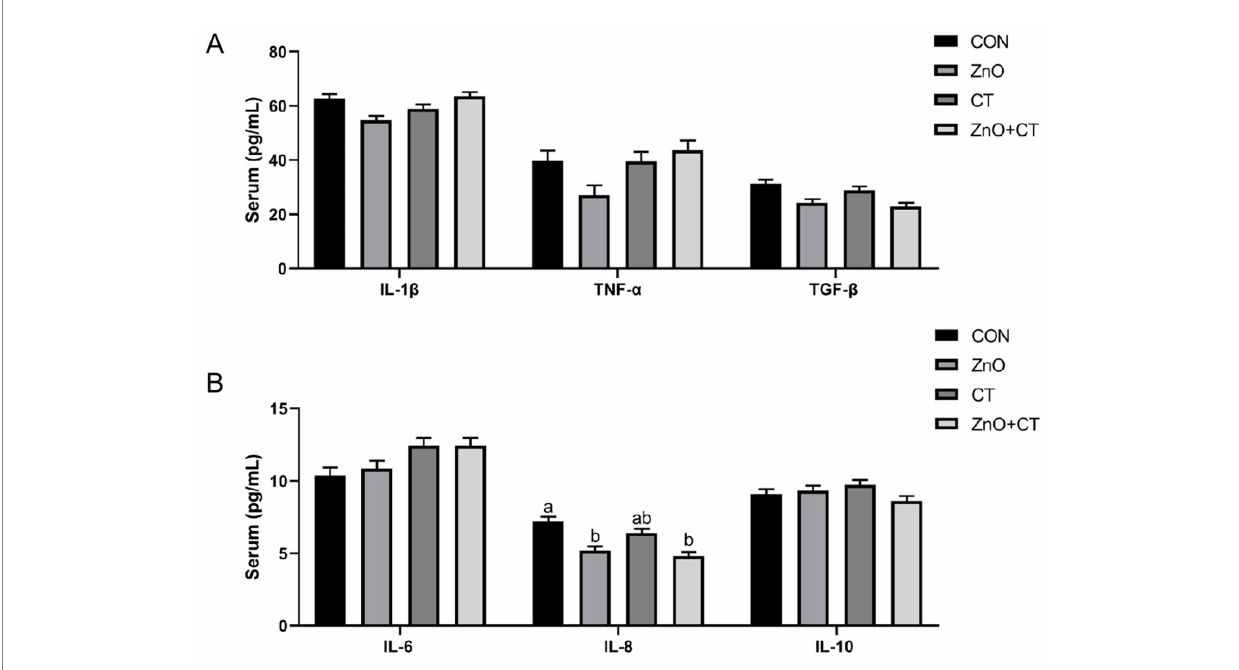
FIGURE 2 Effects of ZnO and CT on serum inflammatory factors in weaned piglets under K88-challenged environment. (A) The concentrations of IL-1 β , TNF- α , and TGF- β . (B) The concentrations of IL-6, IL-8, and IL-10. IL-1 β = interleukin-1 β ; IL-6 = interleukin-6; IL-8 = interleukin-8; IL-10 = interleukin-10; TNF- α = tumor necrosis factor; TGF- β = transforming growth factor- β . Values are means and standard errors represented by vertical bars ( n = 6). a,b Means lacking common superscript letter indicated significant differences ( p <